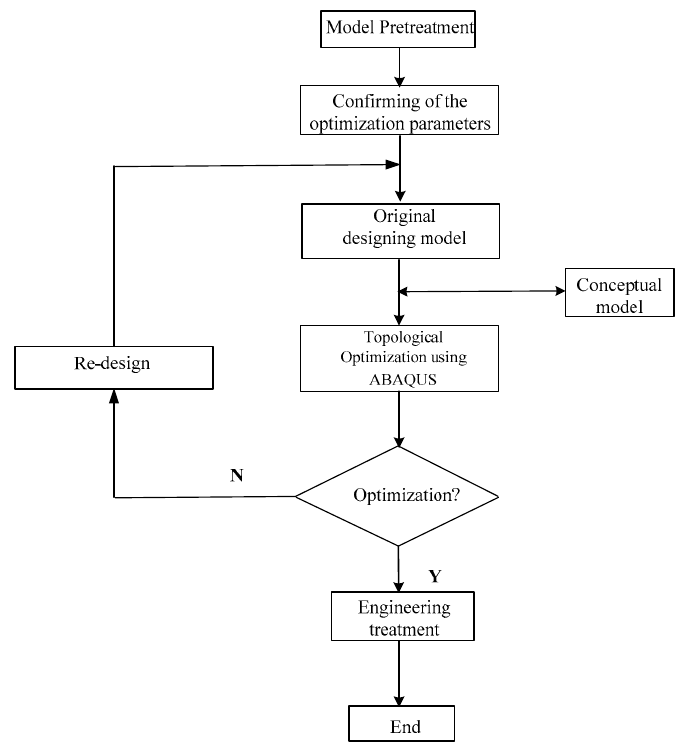
Figure 14. Flowchart of the topological optimization.